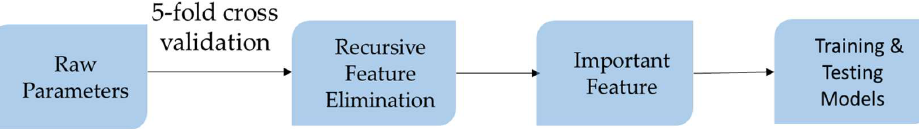
Figure 5. Flowchart of extracting features. Table 3. Raw parameters including EIM parameters of seven muscles and body information of sub- jects.